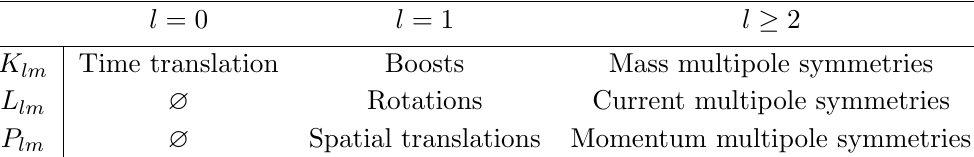
Table 1 . Multipole symmetries and the Poincar(cid:19)e